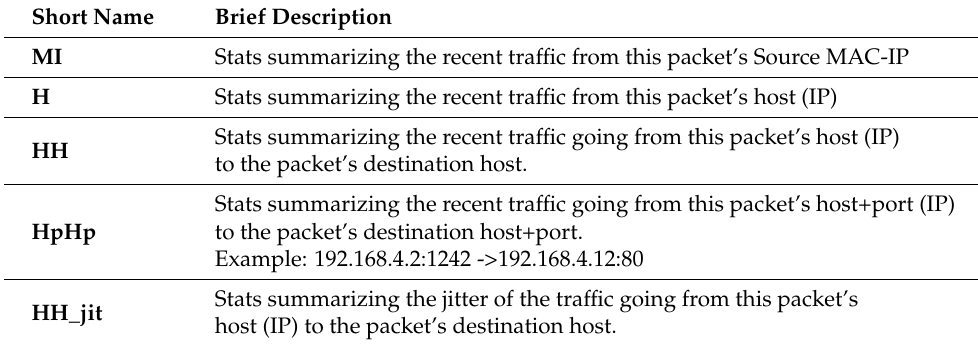
Table 2. Feature